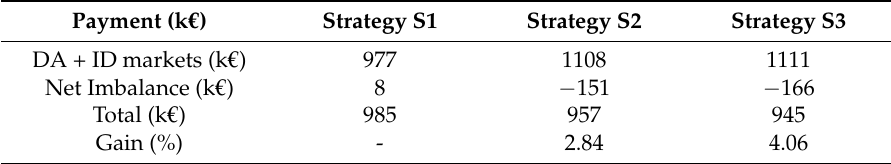
Table 6. Aggregator annual payment from the participation in the DA plus ID